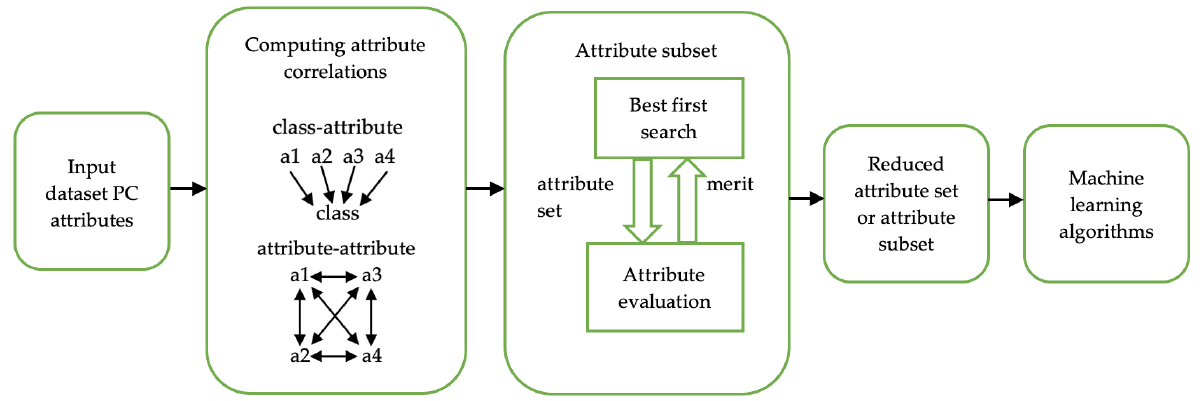
Figure 5. Phases of correlation-based feature selection method.